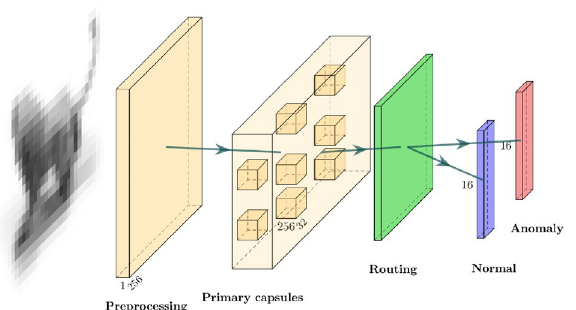
Figure 1. Capsule Networks architecture. Primary capsules are formed out of a convolutional layer set. Those layers have the same input and their output is combined for routing. The decoder is not shown. Architecture for MNIST-like experiments is shown here and the changes we made for different cases are described in the respective